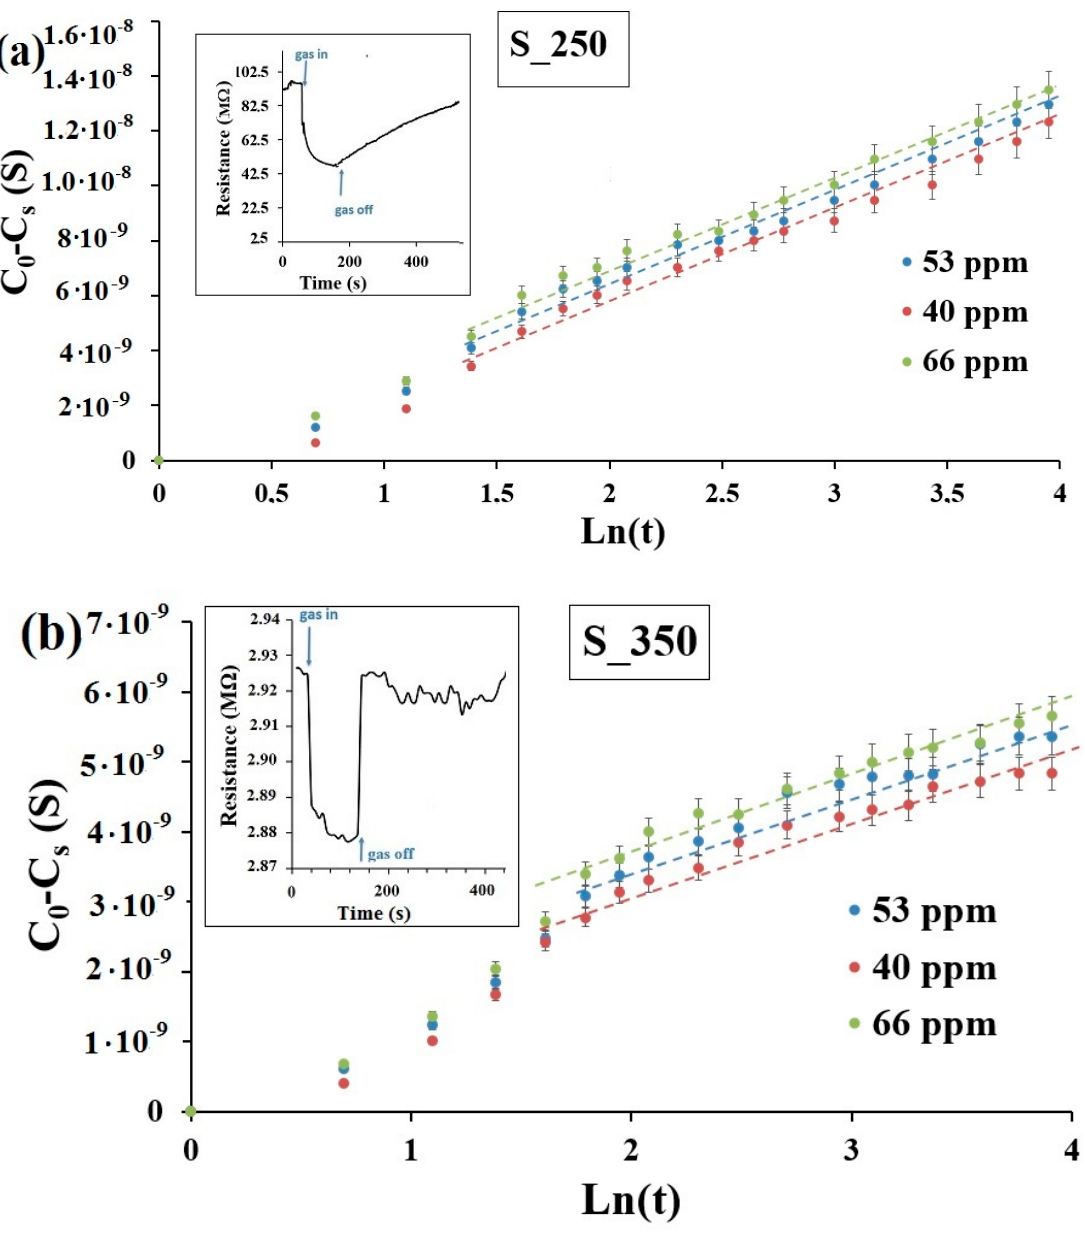
Figure 7. Elovich plot for NO 2 adsorption on the surfaces of the S_250 ( a ) and S_350 ( b ) samples at 45 °C. The insets indicate the typical dynamic of sensor response to 53 ppm of NO 2 gas.